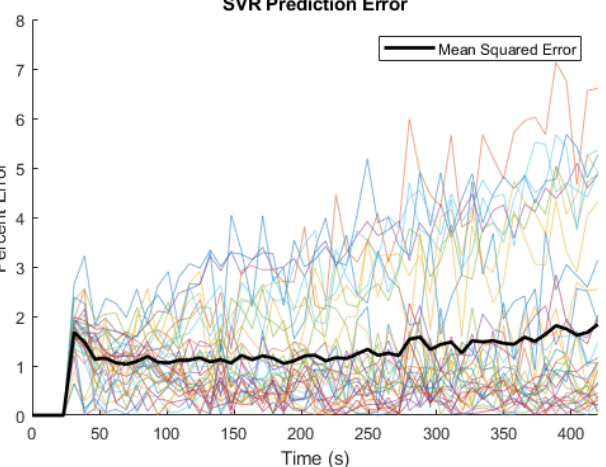
Figure 9. Normalized error between the measured rod temperature and SVR predicted rod